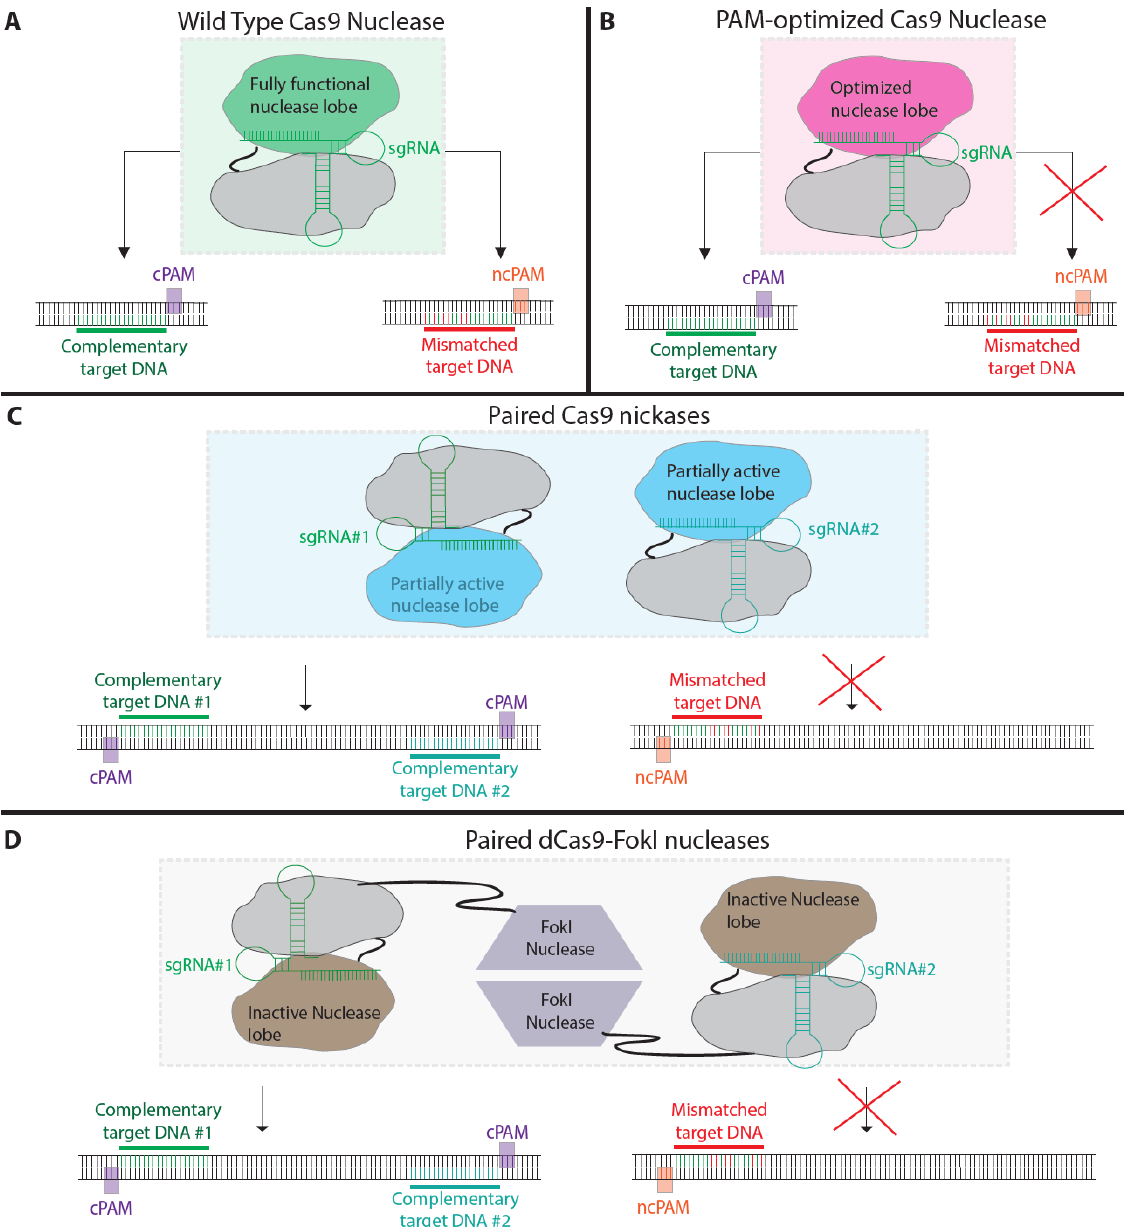
Figure 3. Modified Cas9 strategies to reduce off-target mutagenesis. ( A ) Wild type Sp Cas9 nuclease can bind and cleave either sgRNA-complementary (green) or -mismatched (red) DNA with canonical PAM (cPAM) or noncanonical PAM (ncPAM), respectively; ( B ) PAM-optimized Cas9 nuclease induces cleavage specifically to cPAM complementary DNA; ( C ) A pair of SpCas9 nickases ( i.e ., D10A mutant) must bind to two closely spaced DNA sequences on opposite strands in order to induce single strand nicking on each strand and result in full cleavage of the target DNA. The binding of a Cas9 nickase to a non-specific site will induce nicking but not a double strand break; ( D ) Deactivated Sp dCas9 ( i.e. , D10A and H840A mutant) fused with a FokI nuclease must bind to two closely spaced DNA sequences in order for dimerization of the FokI nuclease and cleavage to occur. Nonspecific binding at an off-target site will not induce